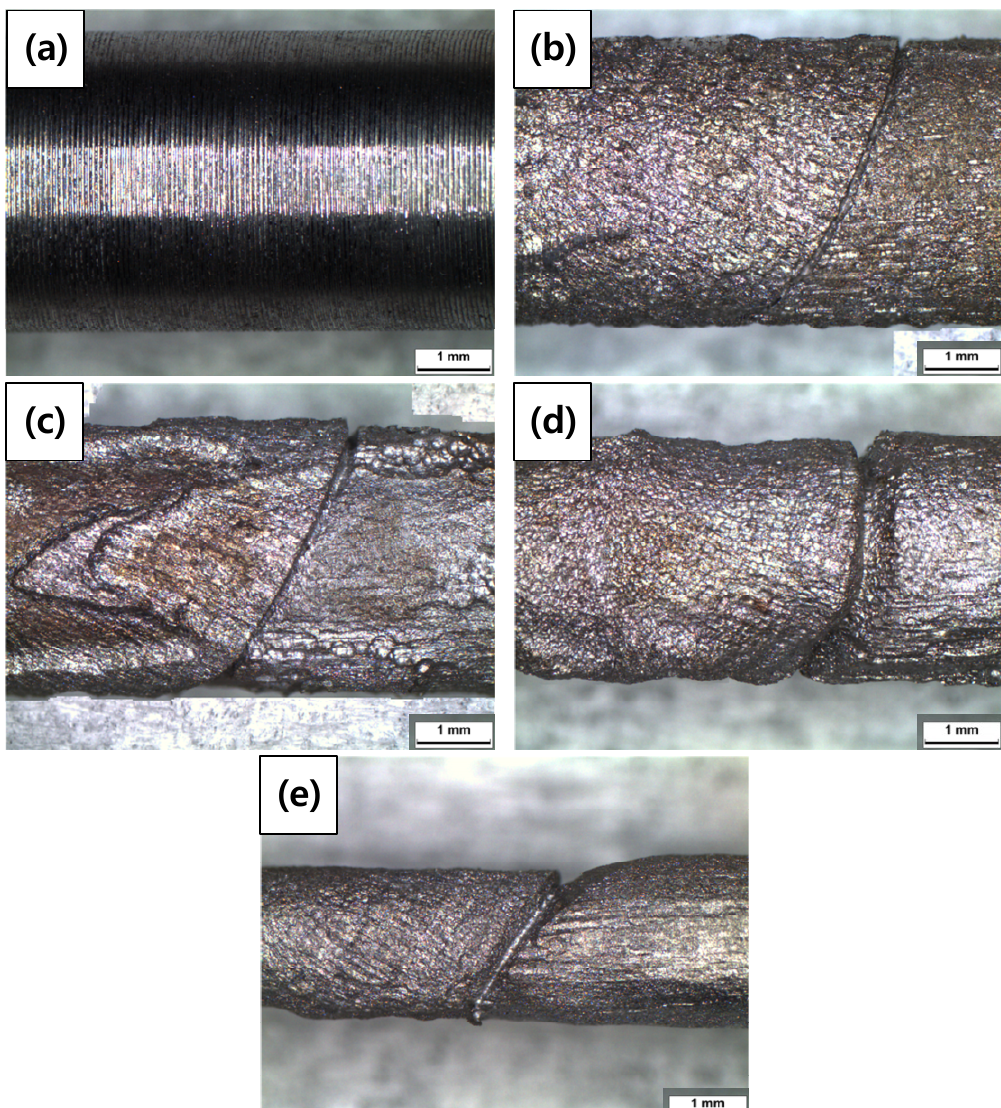
Figure 8. Optical microscope (OM) images of the welded carbon steel specimens after a galvanostatic test according to charge amounts: ( a ) 0%, ( b ) 3%, ( c ) 10%, ( d ) 20%, and ( e ) 50% reduction ratios. Table 7. Measured diameter reduction of the corroded tensile specimens.